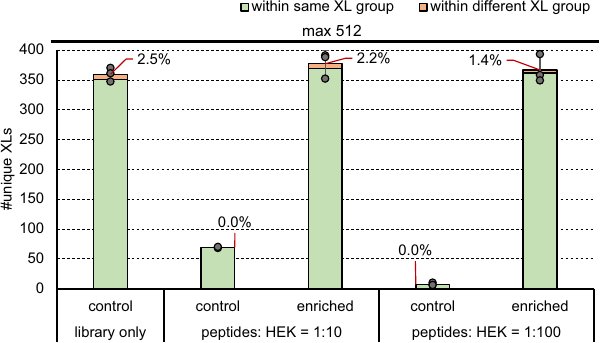
Fig. 7 Af fi nity enrichment of DSBSO crosslinked synthetic peptides from a complex environment. Average number of unique crosslinks after acquisition using a stepped HCD MS2 strategy identi fi ed in the DSBSO crosslinked enrichable library with or without spiking using linear tryptic HEK peptides as indicated. Controls were directly used for measurement; enriched samples were subjected to af fi nity enrichment. Error bars indicate standard deviations of average values, experimentally validated FDR is shown as callout, n = 3 independent samples acquired on different days. Source data are provided as a Source Data fi